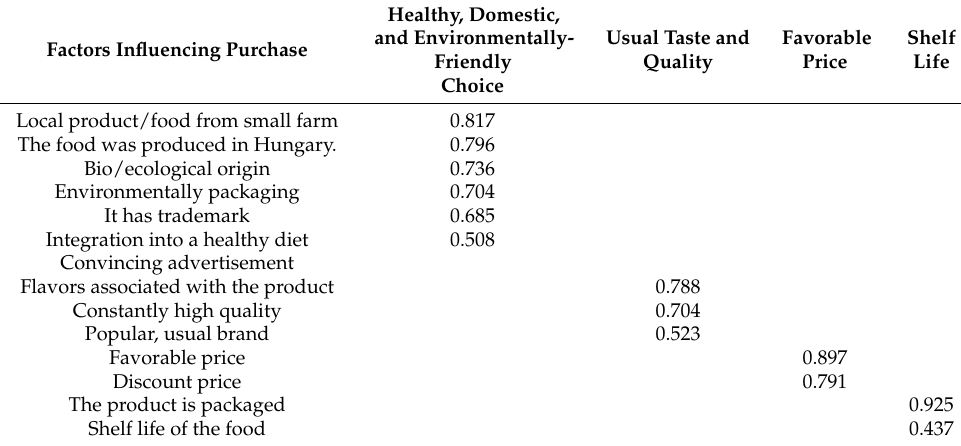
Table 5. Results of exploratory factor analysis (N = 3000).